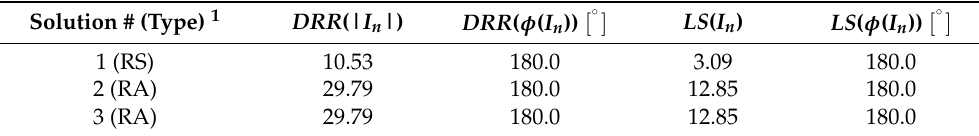
Table 2. Dynamic range ratio and local smoothness of the multiple excitations sets obtained by the initial real case with a linear array of 10 elements.